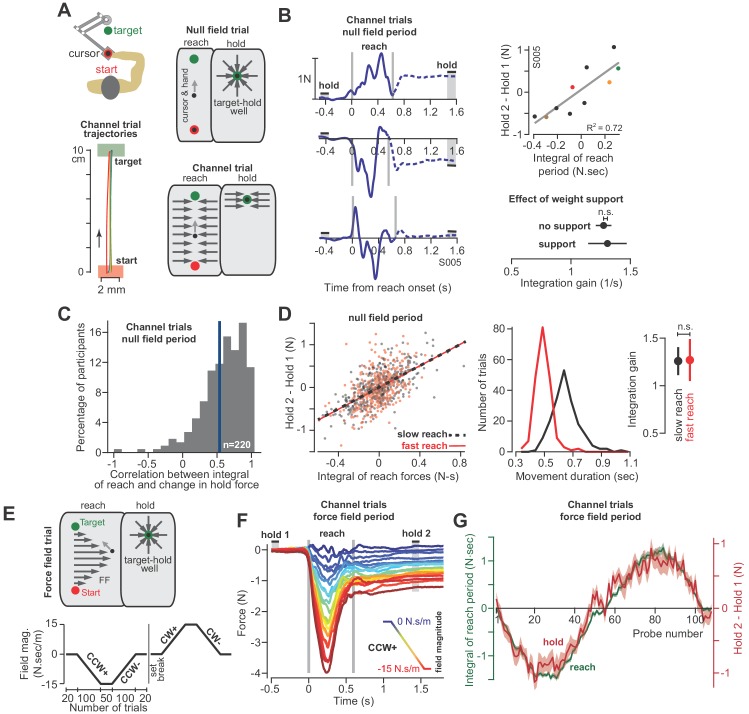
The integral of reaching forces correlates with forces produced during the subsequent hold period.(A) Human participants held the handle of a robotic arm and made point-to-point reaching movements (top). On most trials, participants reached freely to the target. After the reach ended, a target-hold well held the hand in place (null field trial). On some trials, hand trajectory was constrained to a straight line (channel trial, trajectories shown at left). (B) Example lateral force traces on channel trials during the null field period (in a single subject). The bars hold 1 and hold 2 indicate the periods in which holding force levels were quantified. At top-right, we show the correlation between the integral of reach period forces and the change in holding force for this representative subject. At bottom-right, we compare the gain of integration (slope of the line at top-right) between conditions with and without weight support for the arm. (C) We calculated the correlation coefficient between the time-integral of reach forces and holding forces across all channel trials in the null field, within each individual (n = 220). The vertical blue line denotes the mean of the distribution. (D) For each subject, we selected their two fastest and two slowest movements in the null field, resulting in two distributions, with each subject represented equally in each distribution. We then performed linear regression on each distribution separately. Error bars for the integration gain are 95% CI at right. At middle, we show the distribution of reach duration. (E) After the null field period, we gradually introduced a velocity-dependent force field (top). We measured moving and holding forces as subjects adapted and de-adapted to counterclockwise (CCW) and clockwise (CW) force fields (bottom). (F) Each trace represents the force on one channel trial, averaged across participants during the CCW force field adaptation period. The vertical gray bars denote the start and end of the reaching movement. The color of each traces indicates the force field magnitude at each point in the experiment. The hold 1 and hold 2 bars indicate periods over which holding forces were quantified. (G) On each trial, we calculated the time-integral of forces during reaching (green) and compared these to the change in holding force (red). Values are mean ± SEM across all participants. Statistics: n.s. p>0.05.Figure 3—source data 1.The EXCEL source data file contains holding forces and the integral of moving forces as shown in Figure 3.The data are divided into two tabs, ‘data-panels-B-D’ and ‘data-panels-E-G’. For the former, data are provided for all channel trials appearing in the baseline null field period for all healthy participants (n = 220). Here, we also indicate the movement duration and whether or not the arm was supported against gravity. For the latter, data are provided for force field adaptation trials for the participants shown in the corresponding figure panels (n = 32). The adaptation paradigm for these trials is shown in Figure 3E (bottom). The ‘readme’ tab describes all quantities reported in the two tabs containing participant data.